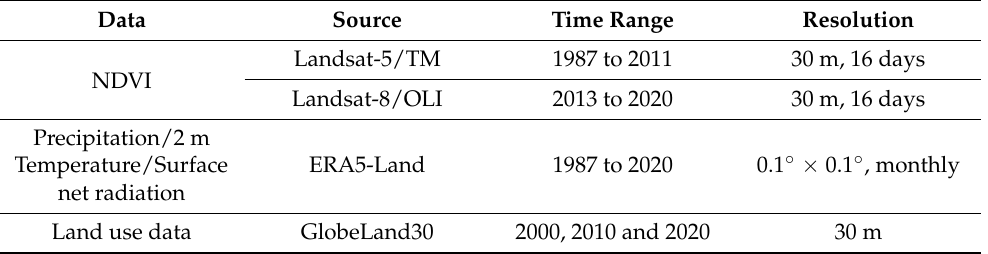
Table 1. Datasets used in this study.